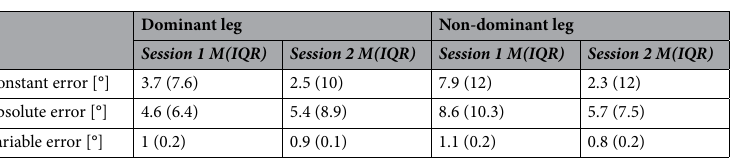
Table 1. Constant, absolute and variable angular error displayed per leg dominance and session. M median; IQR interquartile range.